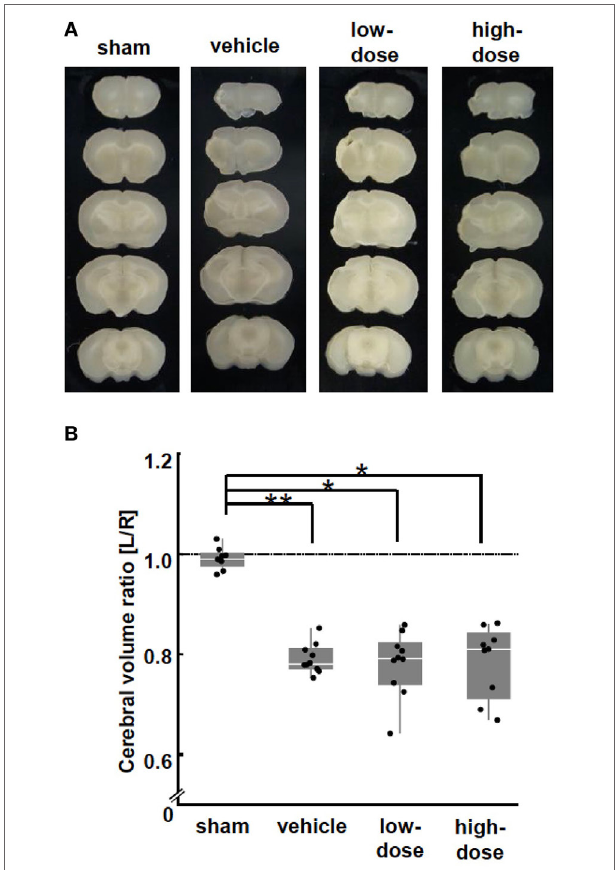
FigUre 4 | Morphological brain injury. (a) Representative images of brain coronal sections at P28 (2 weeks after the cells or vehicle administration). (b) At P28, middle cerebral artery occlusion caused a significant volume loss in the ipsilateral hemisphere in the vehicle group. There was no difference in the volume loss between the UC-MSC group and the vehicle group. ** p <